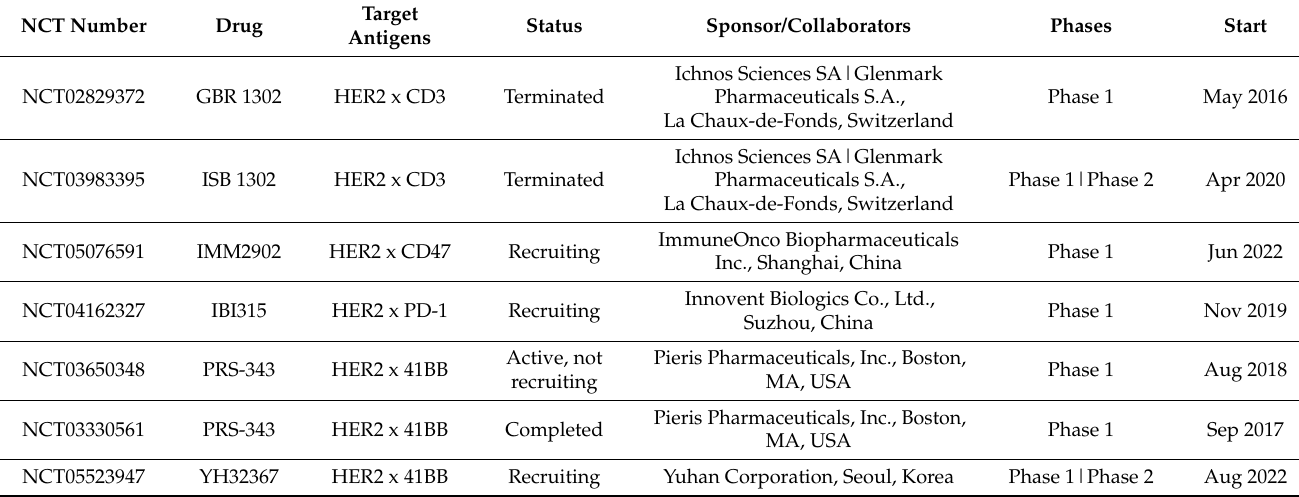
Table 1. HER2 bispecific antibodies in clinical trials for the treatment of HER2-positive tumors, including breast